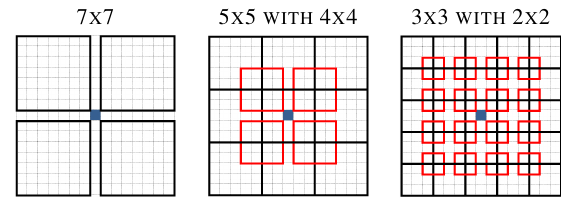
Figure 1: Multi-scale patches: Pixels are displayed grey, 2 X 2 and 4 X 4 patches red, 3 X 3, 5 X 5, and 7 X 7 black.